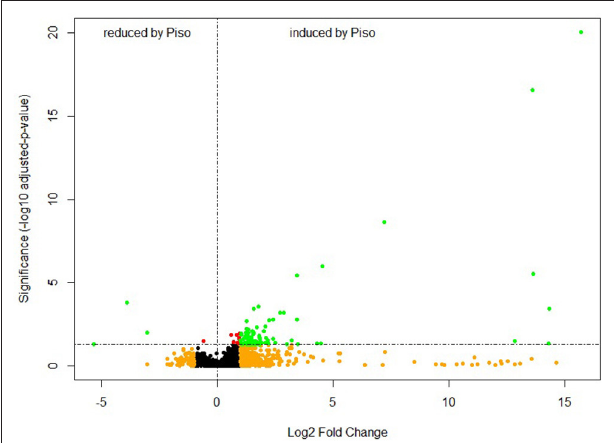
FIGURE 3 | Pre-symbiotic interaction induces a large number of metabolites in E. grandis roots. Volcano plot showing the varied molecular features in E. grandis root tips after pre-symbiosis with P. microcarpus ( n = 24) for 24h in comparison to control root tips ( n = 4). The metabolite profiles are derived from LC-MS (ESI + mode). The y-axis and x-axis correspond to the mean fold change of Pisolithus -interacting root tips in comparison to control, and the significance value in terms of p -value (adjusted by Bonferroni-method). Red = p < 0.05; Orange = fold change > 2; Green = p < 0.05 and Intensity fold change >